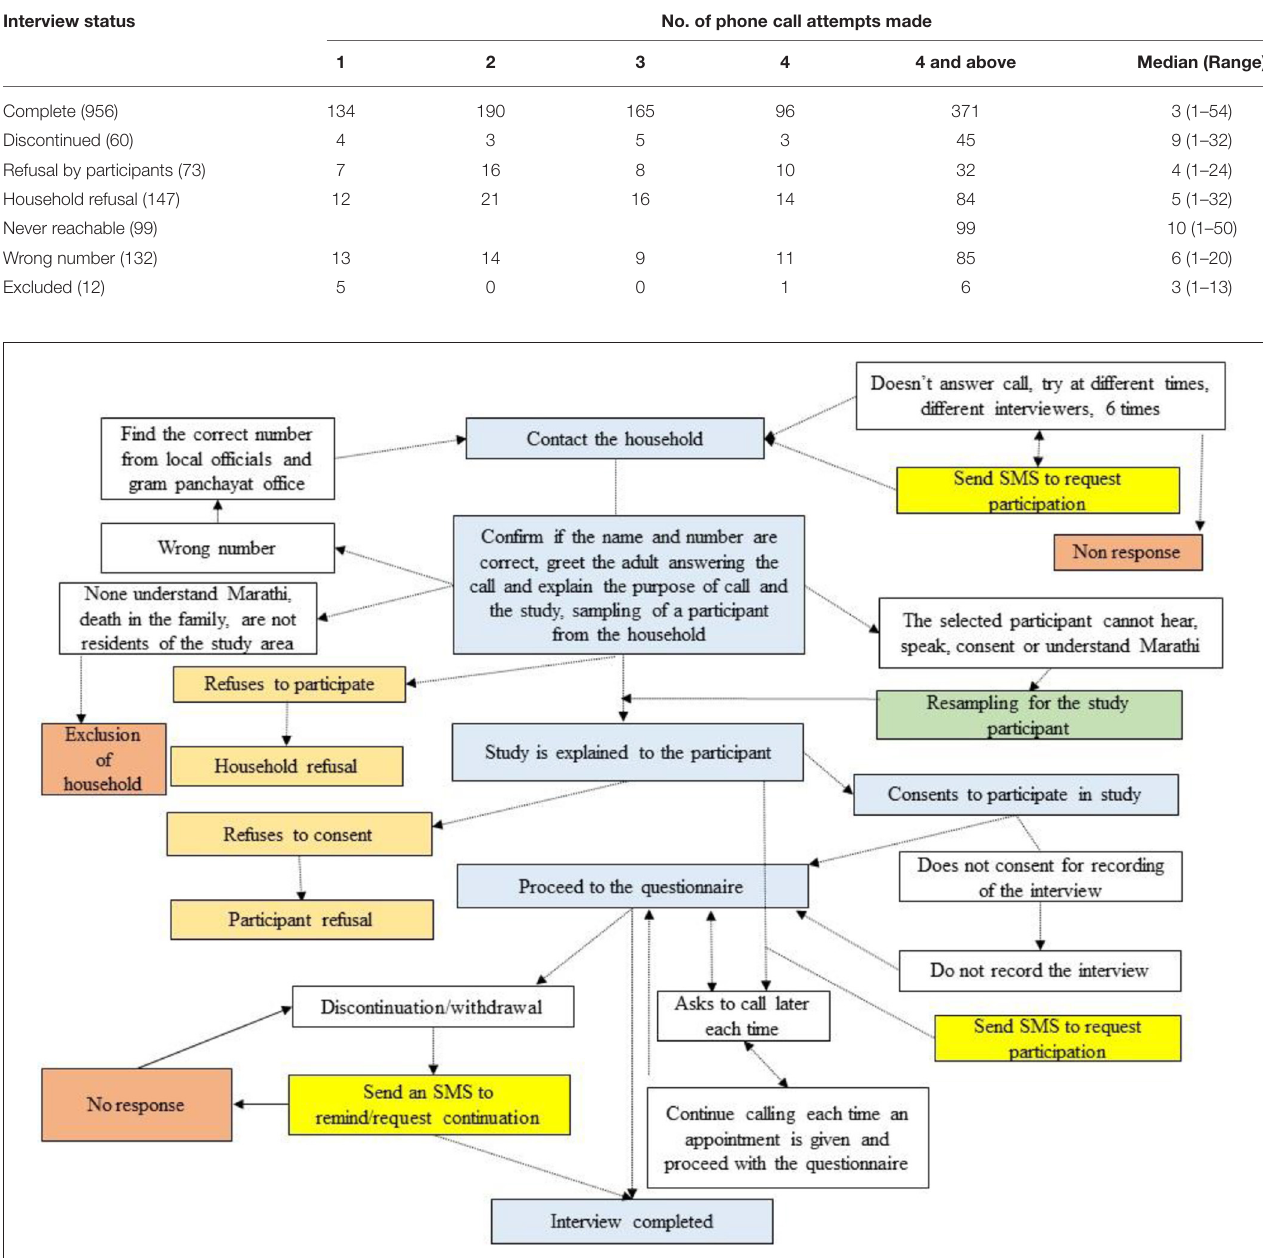
TABLE 1 | No. of phone call attempts made and the interview status.